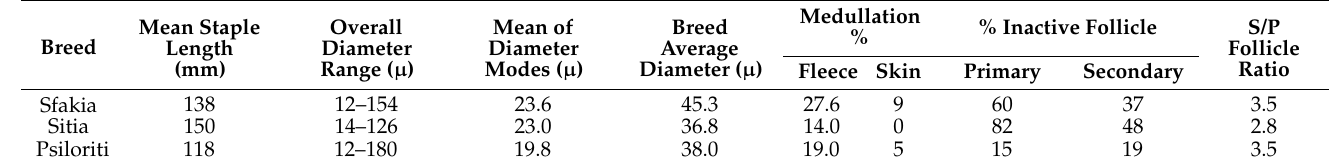
Table 1. Fleece measurements of Cretan Zackel adopted/modified, from reference